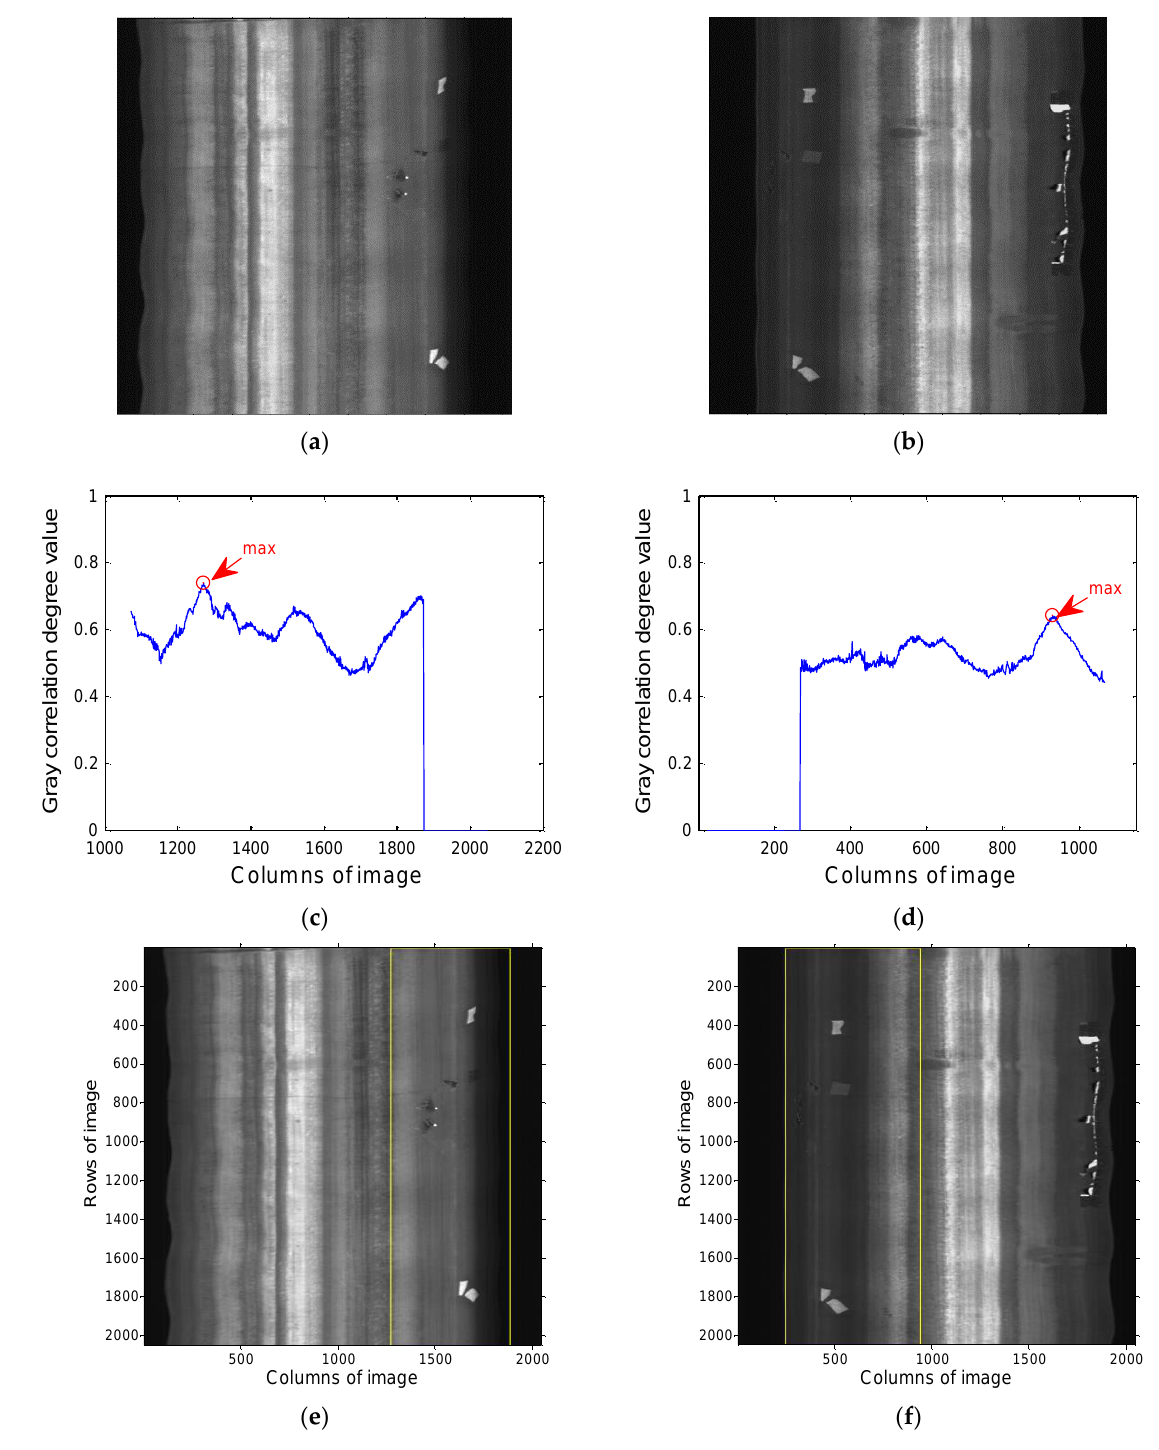
Figure 6. Registration of overlapping regions based on the grayscale. ( a ) Left image. ( b ) Right image. ( c ) Gray correlation curve of the left image. ( d ) Gray correlation curve of the right image. ( e ) Registration results of the overlapping region of the left image. ( f ) Registration results of the overlapping region of the right image.